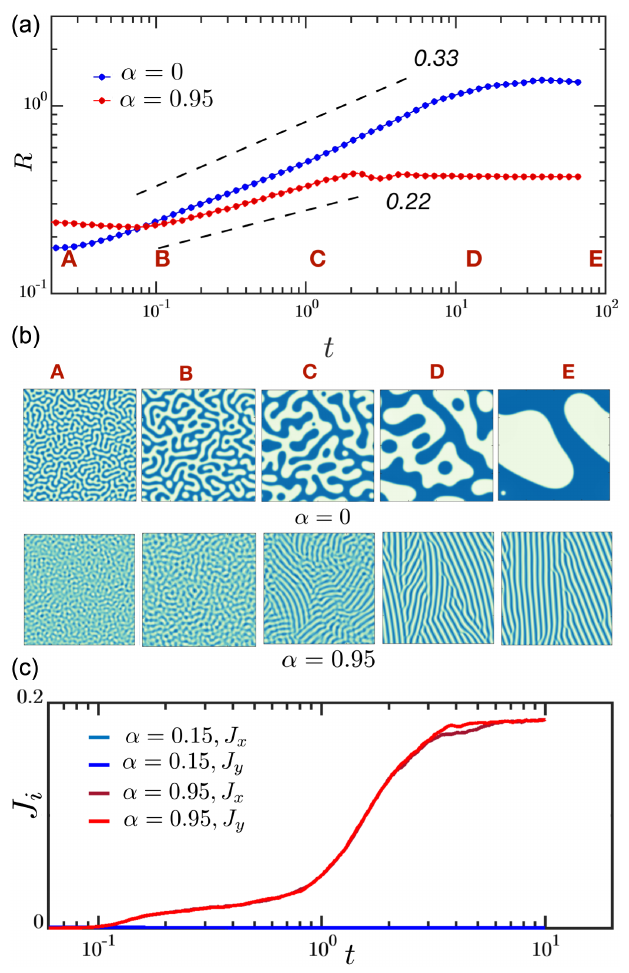
FIG. 3. Dynamics in the NRCH model. (a) Coarsening dy- namics for equilibrium bulk phase separation ( α ¼ 0 ) and formation of self-propelled bands in the active case ( α ¼ 0 . 95 ). (b) A – E show simulation snapshots over time. We note the formation of lamellar domains in C, which coarsen in D and E to the final state in Fig. 1(f). (c) Time evolution of the polar-order parameter as measured by the components of the fluxes J x and J y , obtained by averaging over 250 randomly generated conditions. For α ¼ 0 . 95 , the order parameter satu- rates to a value of approximately 0.1, while for α ¼ 0 . 15 , it decays to zero. Parameters for the free energy are as in Fig. 1. System sizes of 401 × 401 and 201 × 201 are used in simu- lations to calculate the coarsening length scale and current J , respectively. Time stepping is fixed at 10 − 4